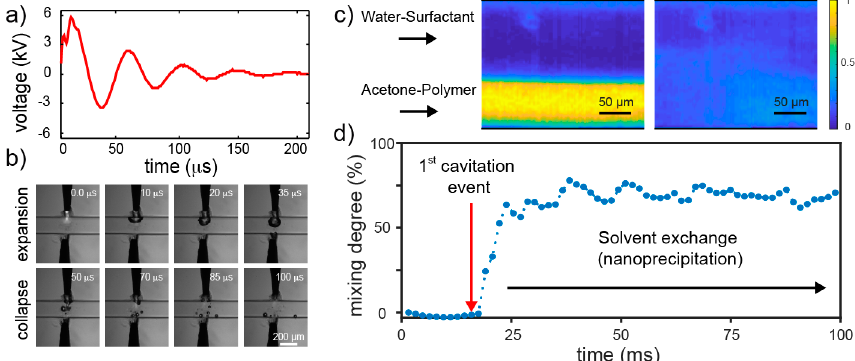
Figure 2. Micromixing with spark-generated cavitation bubbles. ( a ) Typical voltage pulse produced with the spark generator. ( b ) Time-resolved images showing the dynamics—formation, expansion, and collapse—of a cavitation bubble generated using a single high-voltage pulse. The flow is from left to right. ( c ) Surface plots of the dye intensity before and after the first cavitation event and within a region of interest located 200 µm downstream from the electrodes position. ( d ) Degree of mixing vs. time upon the arrival of a sequence of high-voltage pulses with a frequency of 128